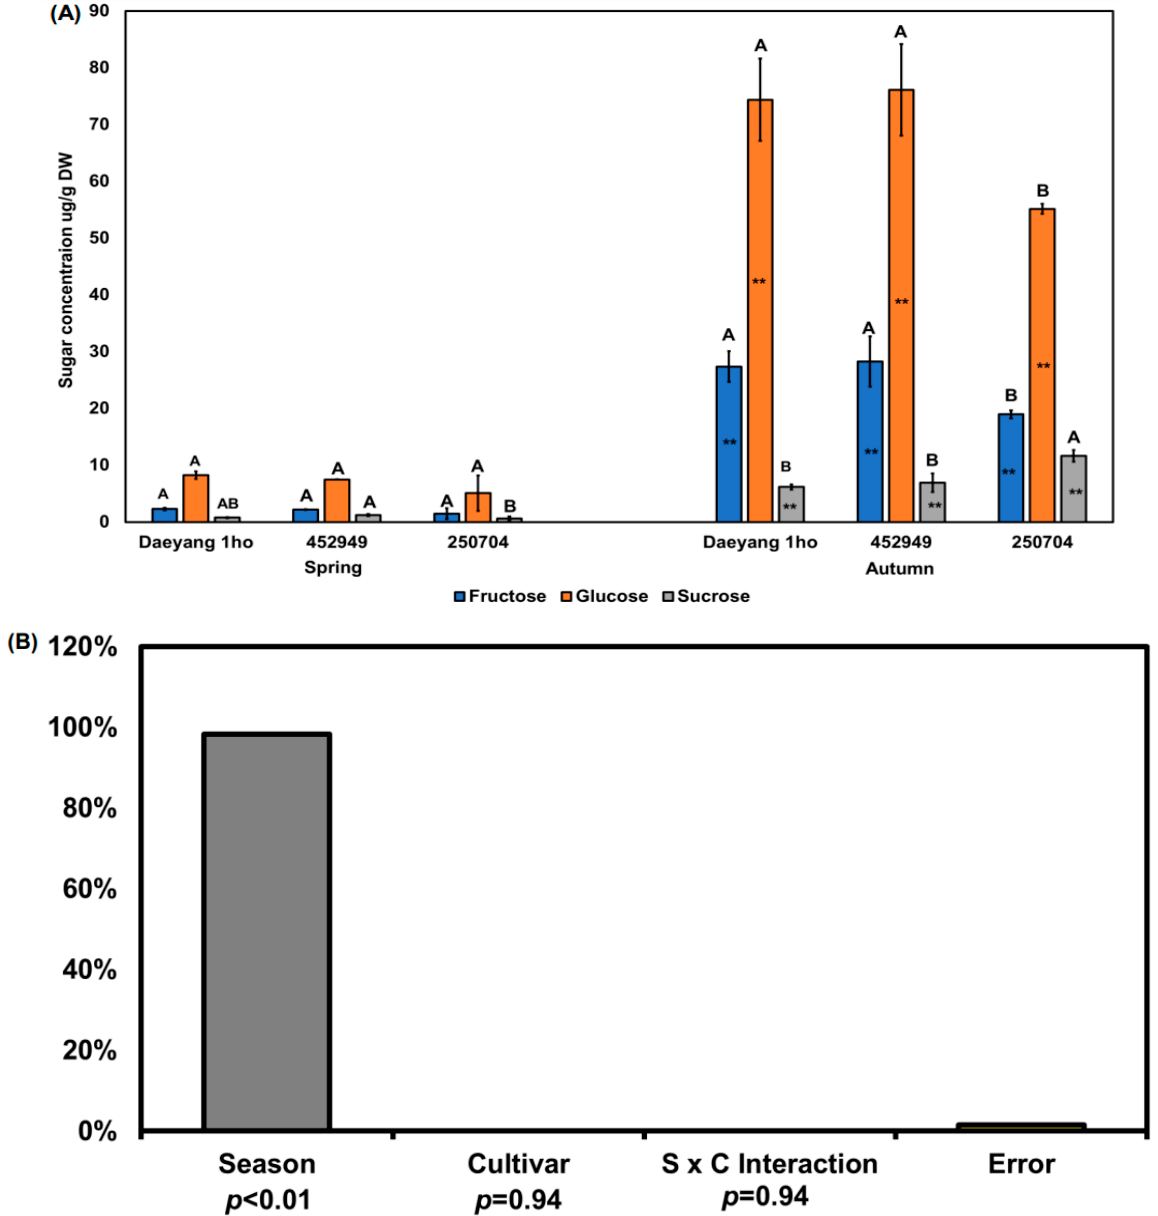
Figure 6. ( A ) Fructose, glucose, and sucrose concentrations in the roots of three different radish cultivars in spring and autumn 2020. Different capital letters above the error bars indicate significant differences among cultivars within the same season according to Tukey’s HSD test ( p < 0.05). Asterisks (**) inside the bars indicate significant differences between spring and autumn within the same cultivar according to an unpaired t -test ( p < 0.05); ( B ) Two-way ANOVA for raphasatin concentration in radish roots from three different cultivars across two seasons. S × C indicates season and cultivar interaction. % indicated % of explained variation.